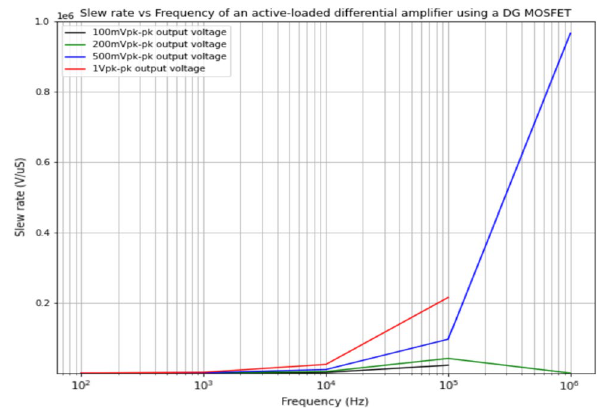
Fig. 16 Slew rates for 100 mV, 200 mV, 500 mV and 1